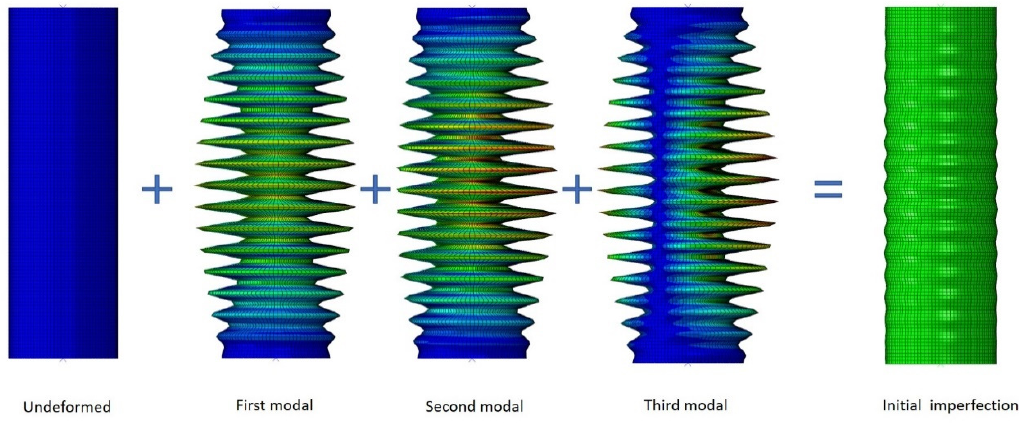
Figure 8. Modal imperfection shape combination of the cylindrical shell, the result is shown in a scale factor of 100. factor of